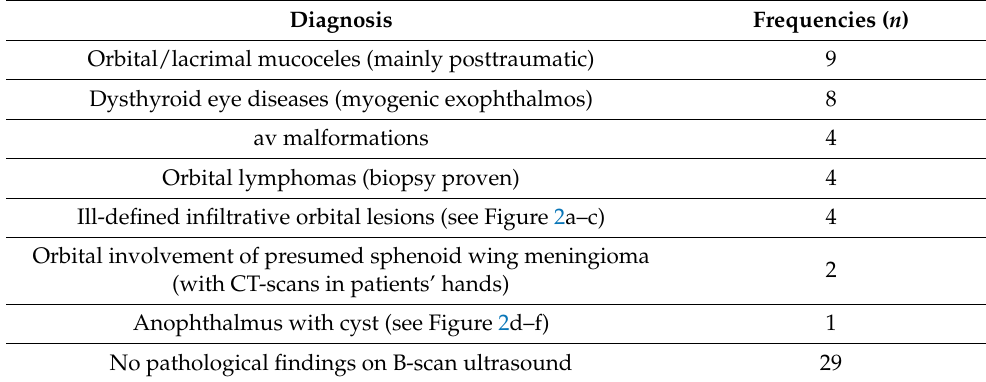
Hospital Eye Department between 2006 and 2019.